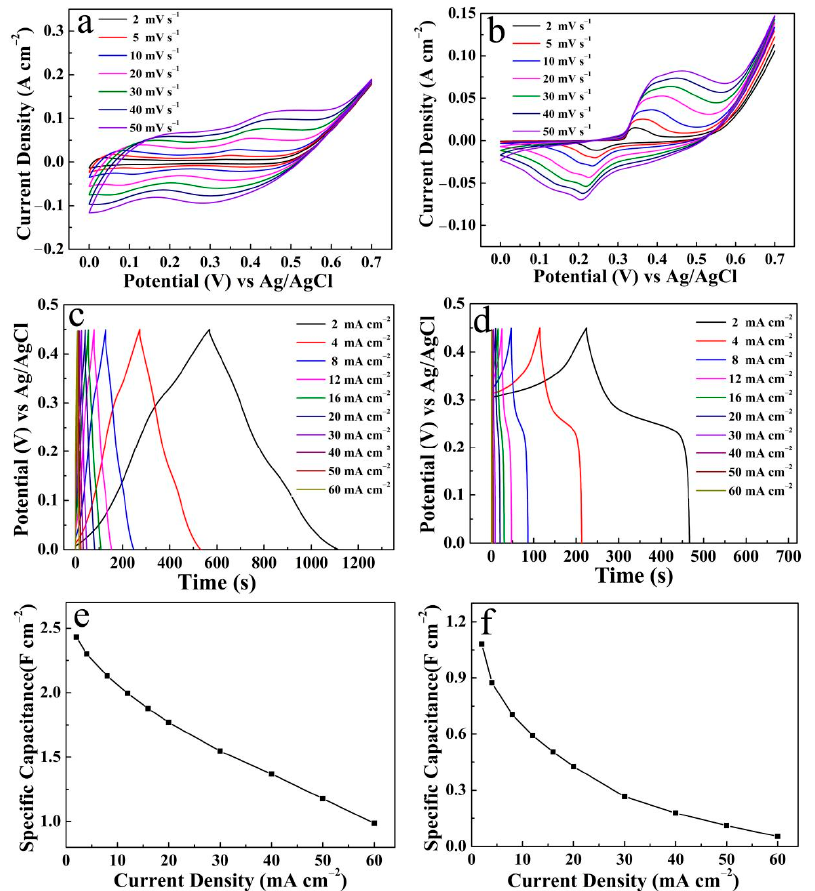
Figure 8. CV curves, GCD curves and C s at different current densities of Co(OH) 2 ( a , c , e ) and Ni 3 S 2 ( b , d , f ). The C s retention of the Co(OH) 2 /Ni 3 S 2 electrode is presented in Figure 9. It can be observed that C s reaches 90.63% at the 600th cycle and maintains the initial 84.38% within 5000 cycles.